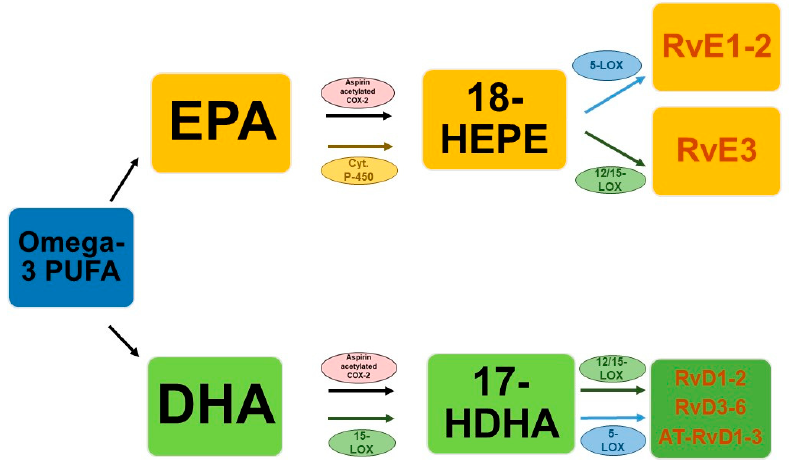
Figure 1. Simplified scheme of the biosynthesis of resolvins.